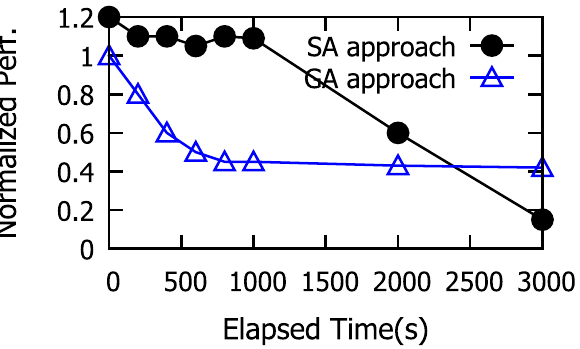
Fig. 10 Overhead of memory consumption. a Effect of counter recycling, b Effect of window size